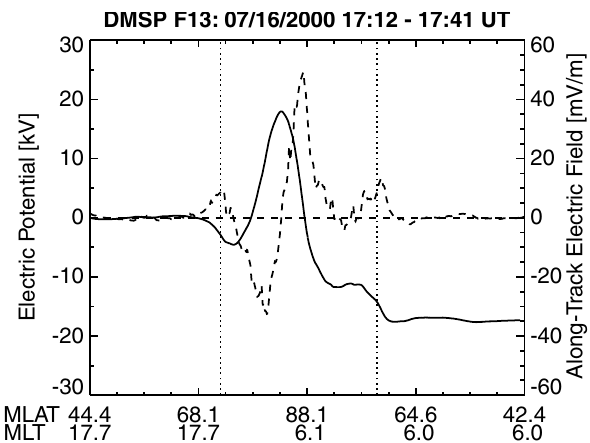
Fig. 13. Electric potential (solid line) derived from the along-track electric field component (dashed line) for the DMSP F13 pass. The vertical dashed lines mark the transition between Region-1 and Region-2 sense Birkeland